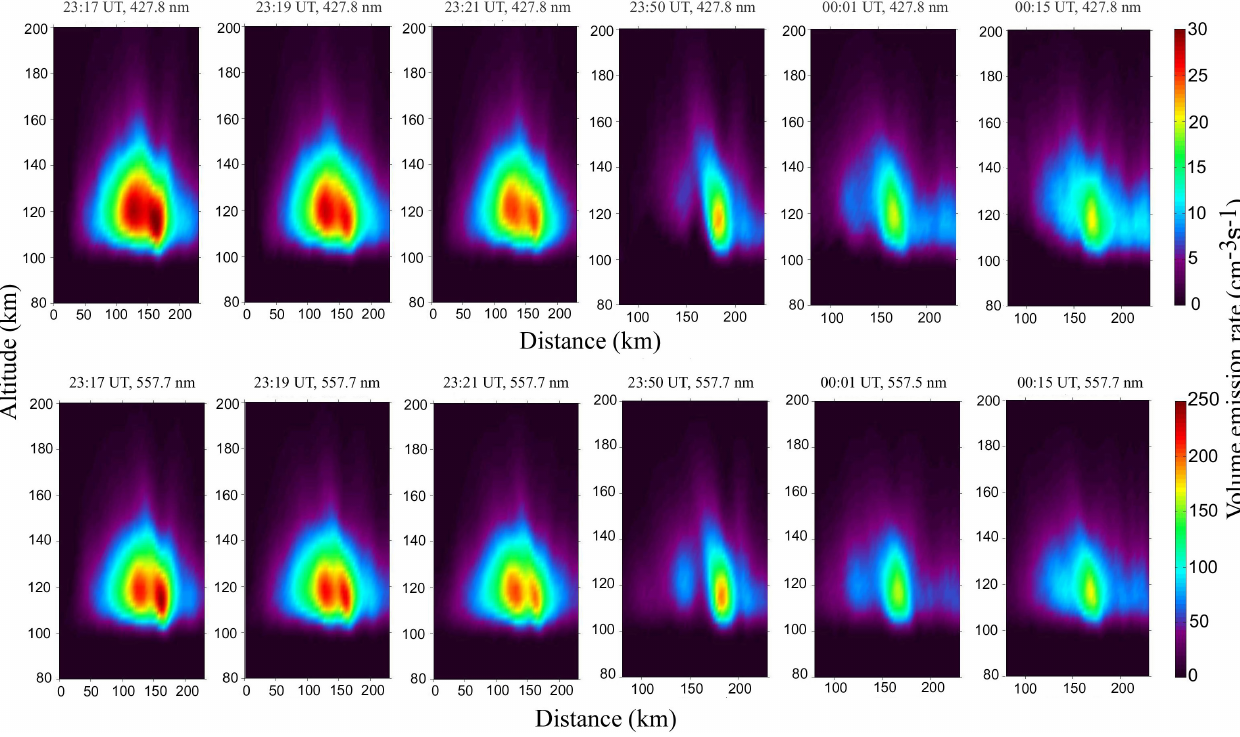
Fig. 4. Tomographic reconstructions of the 427.8- and 557.7-nm volume emission rates on 10–11 February